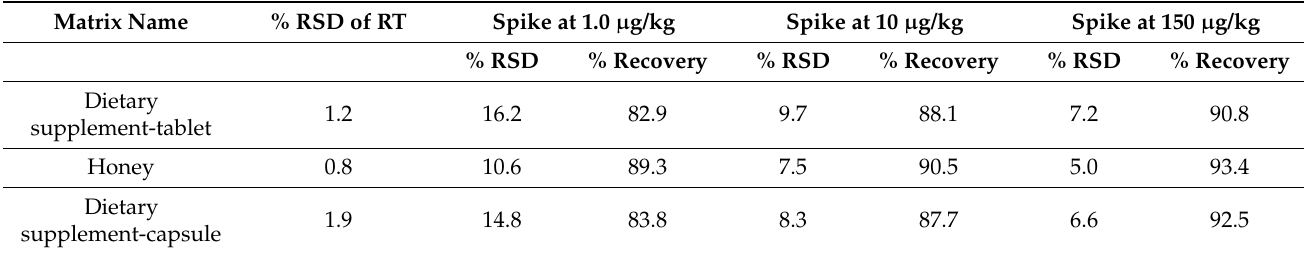
Table 7. Accuracy and Precision on day 1.